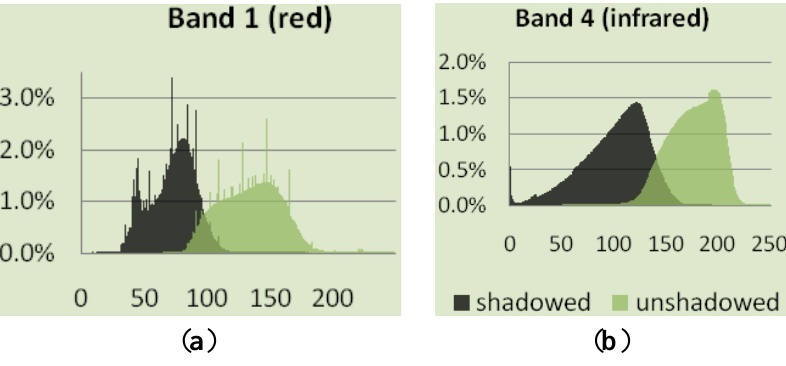
Figure 2. Raw band values, unburned sample area, from ( a ) band 1 (red); ( b ) band 4 (infrared).